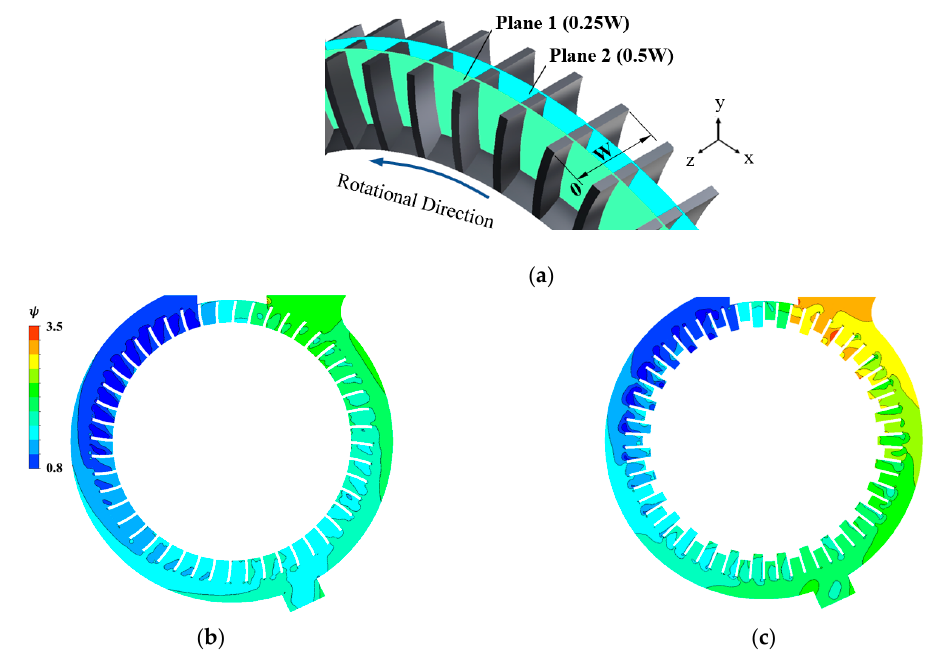
Figure 15. Pressure contours on Plane 1: ( a ) measuring position; ( b ) reference pump; ( c ) optimized